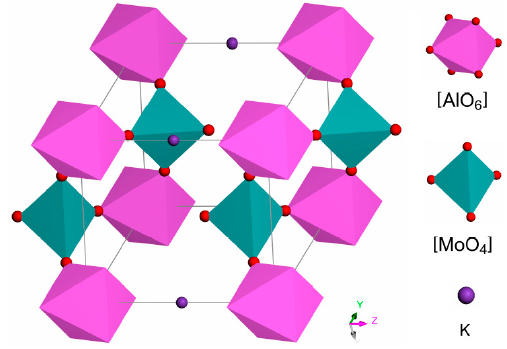
Figure 2. Unit cell of KAl(MoO 4 ) 2 crystal in the hexagonal phase [P3 (cid:3364) m1 ( D 3 d 3 )] space group.